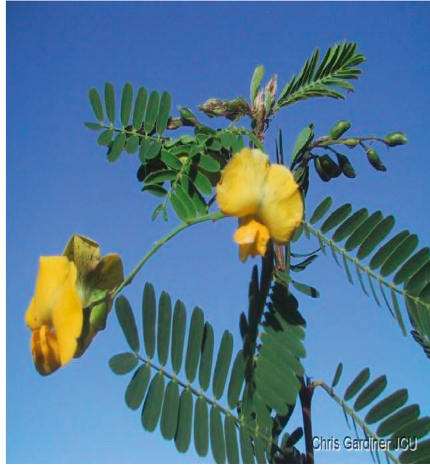
Figure 1: Entire Sesbania sesban